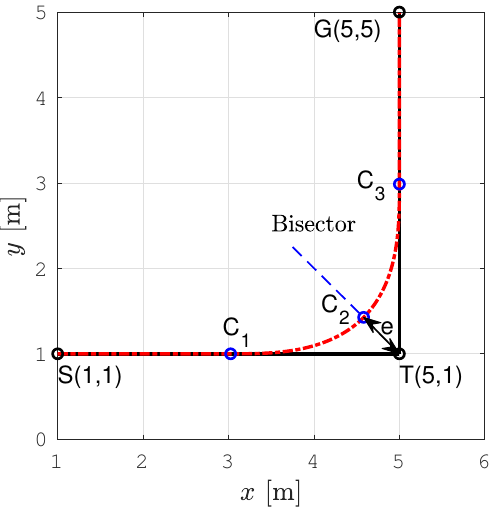
Figure 4. Illustration of the sharp turn smoothing by two